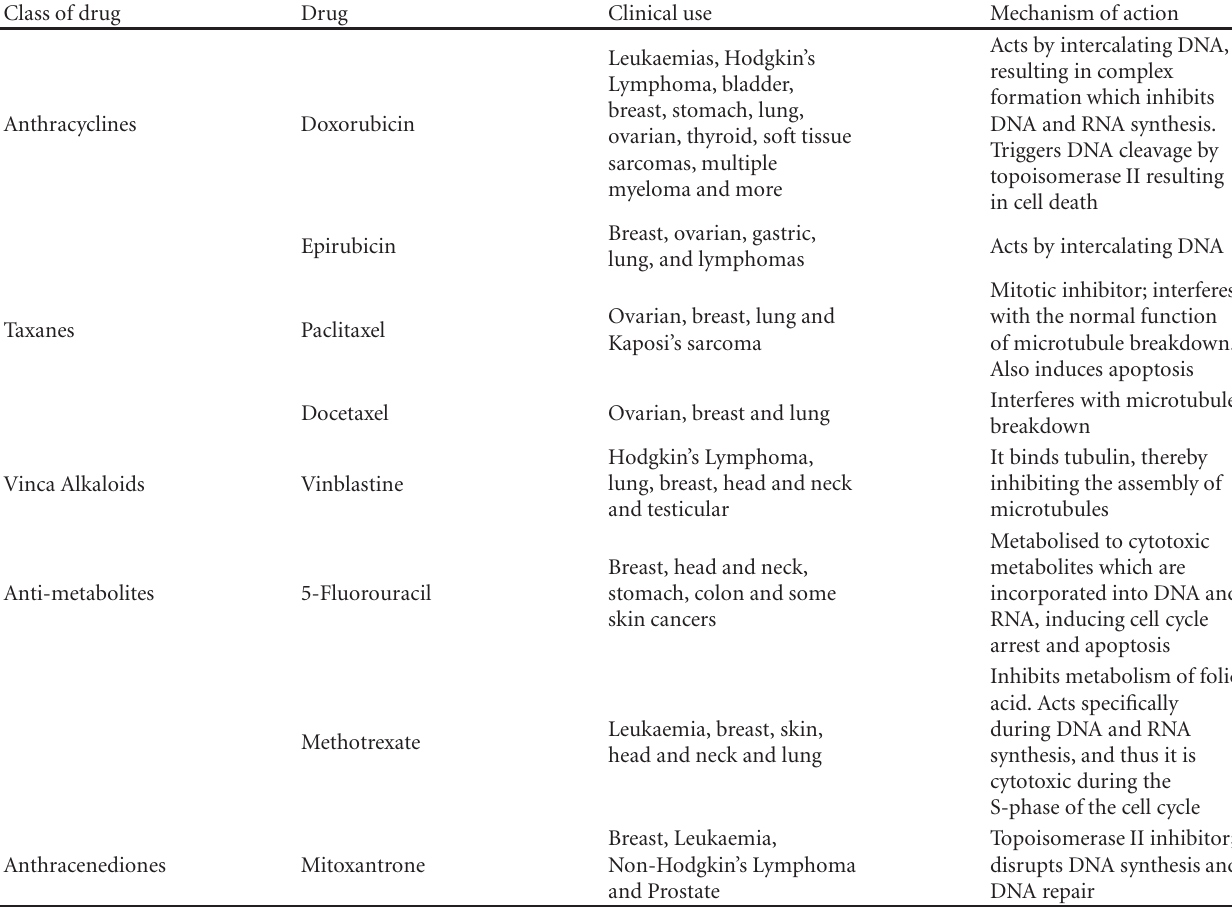
Table 2: Chemotherapy agents used to treat breast cancer subject to